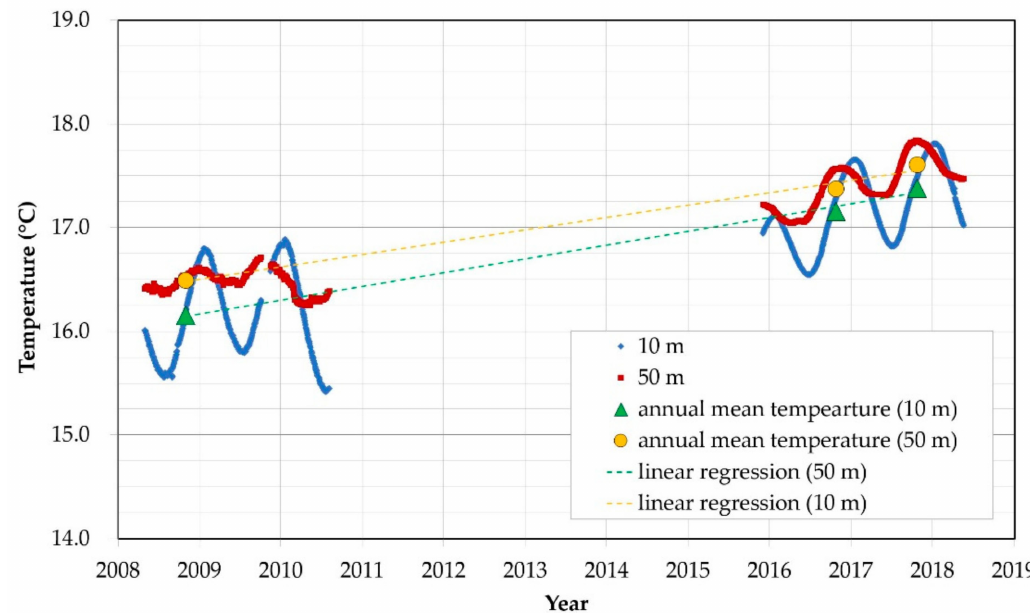
Figure 2. Groundwater temperatures measured at 10 and 50 m depths in the 300 m deep monitoring well for approximately 10 years. The blue and red dots represent the temperature at depths of 10 and 50 m, respectively. The green triangular and yellow circular marks are the annual mean temperature at depths of 10 and 50 m, respectively. The green and yellow dotted lines are the results of the linear regression analysis of the annual mean temperature at depths of 10 and 50 m,